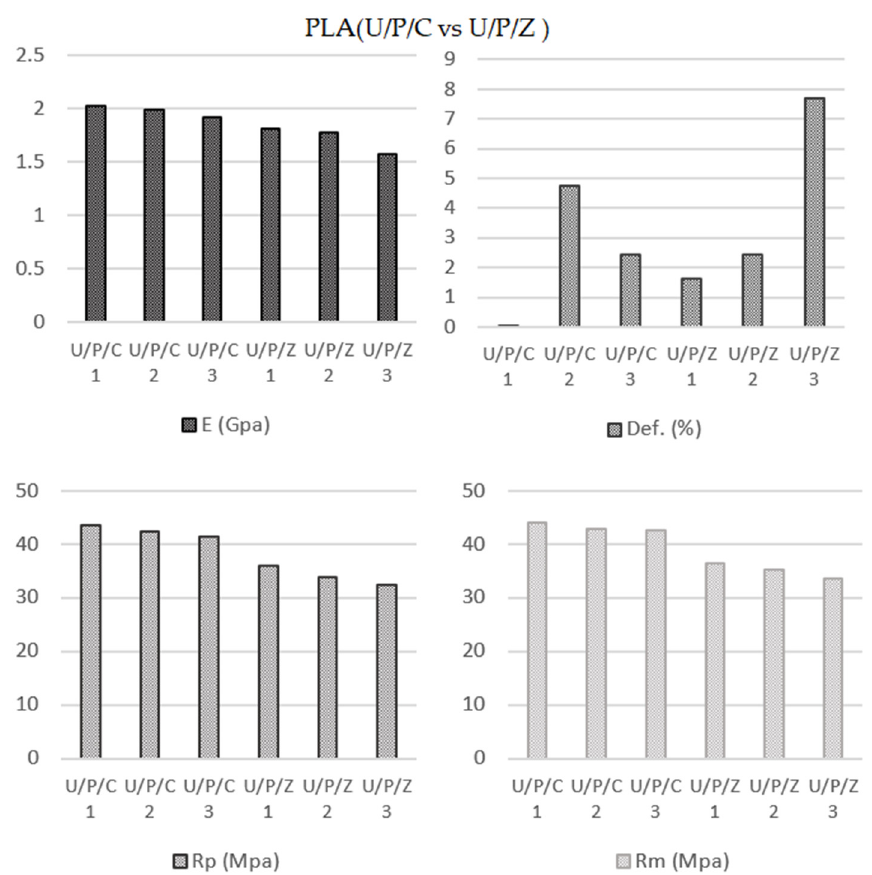
Figure 8. PLA specimens (Concentric vs. Zig-zag) parameters average values.